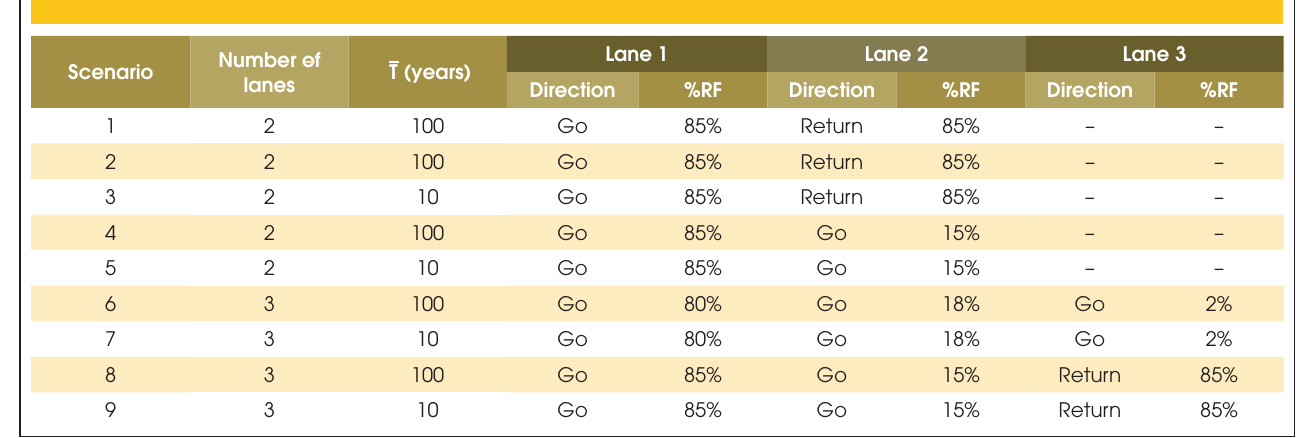
Table 8 – Characterization of traffic scenarios adopted for free